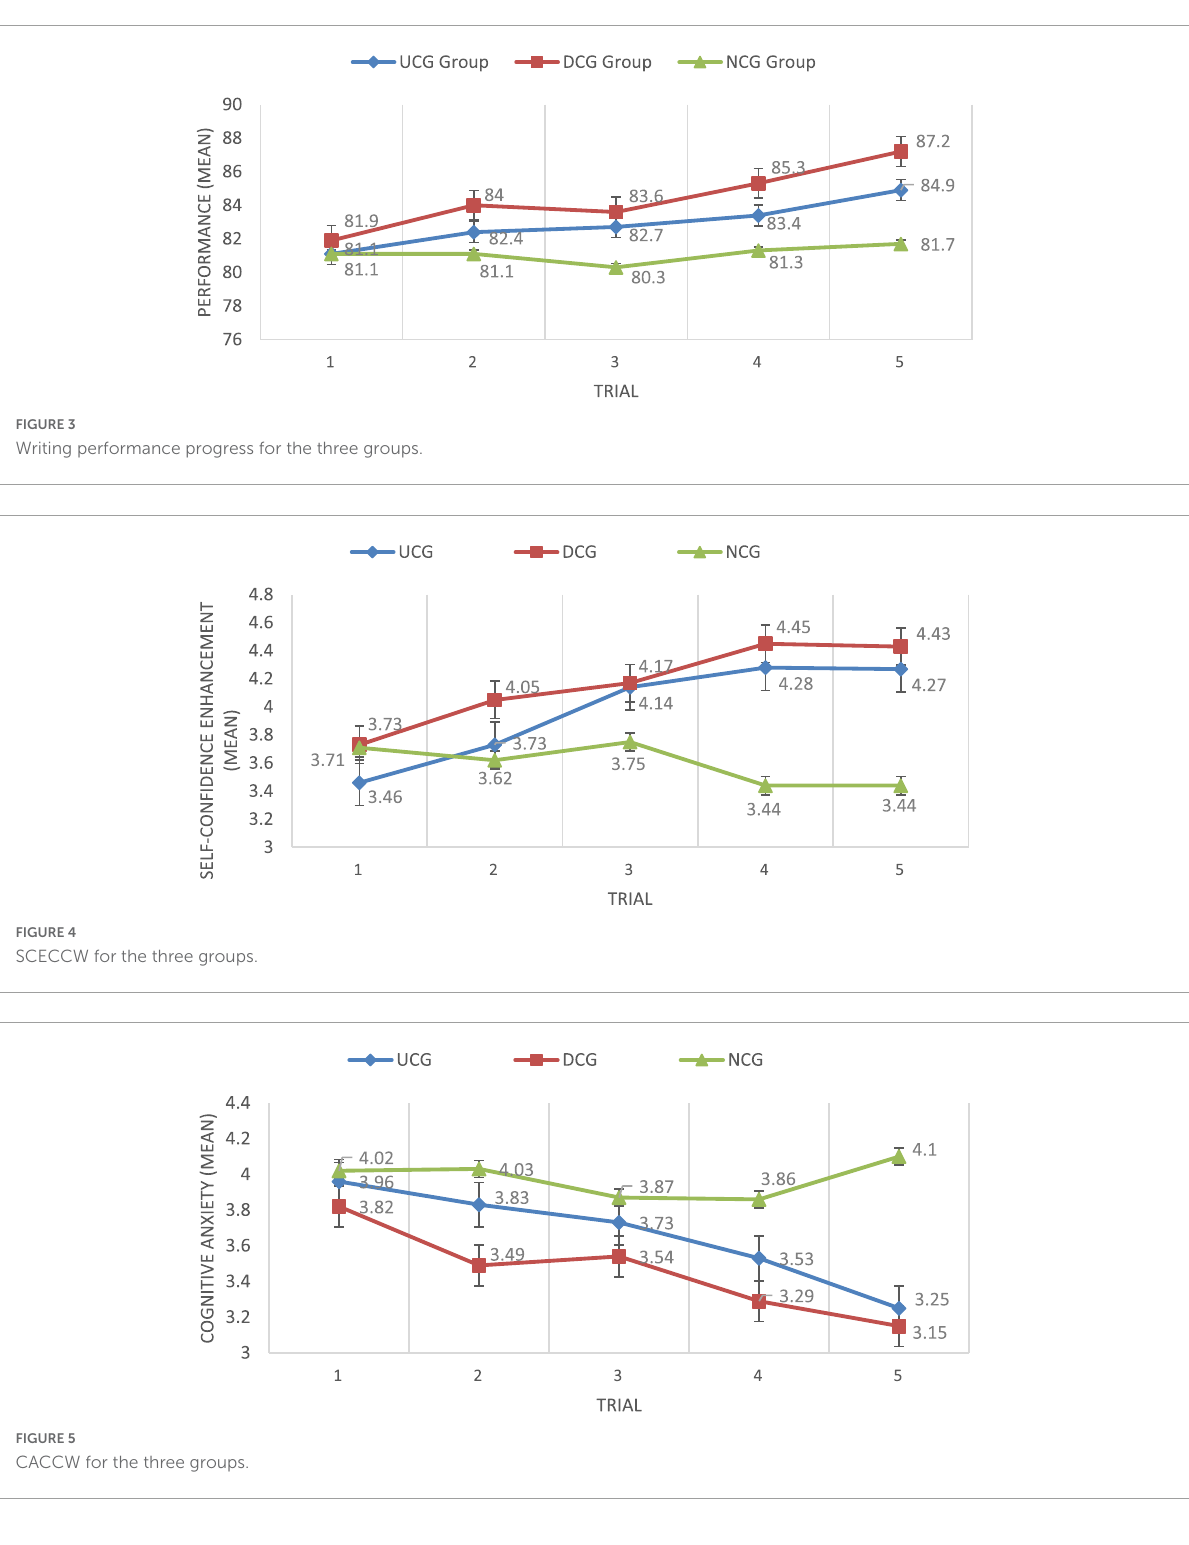
FIGURE5 CACCW for the three